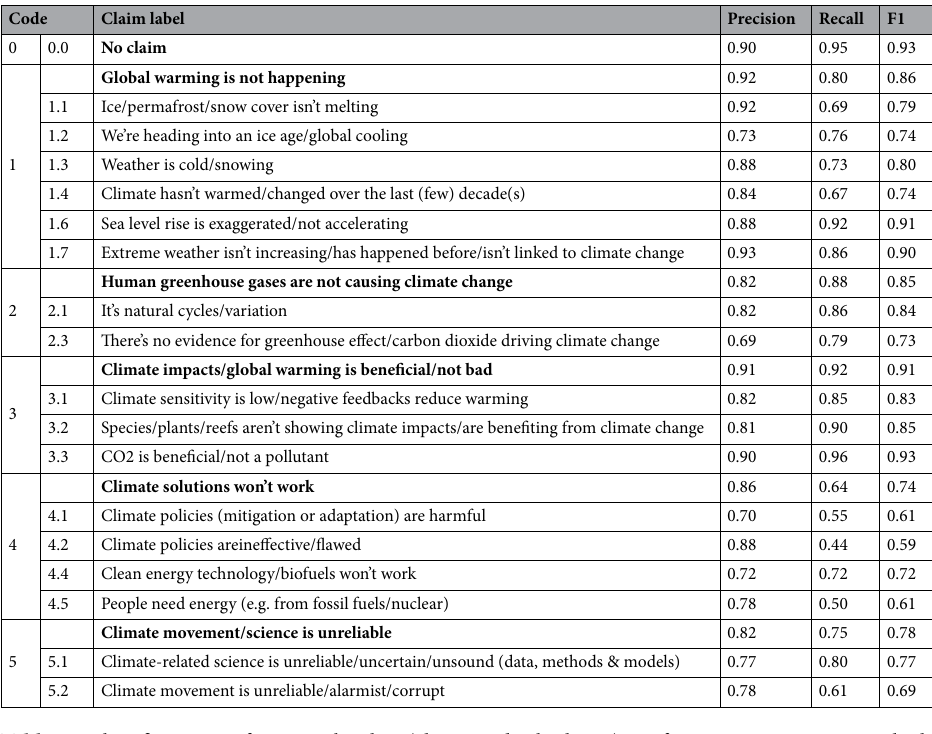
Table 3. Classification performance by class (claims and sub-claims). Performance measures are calculated by assessing the final RoBERTa-Logistic ensemble classifier using the “error-free” validation set (see